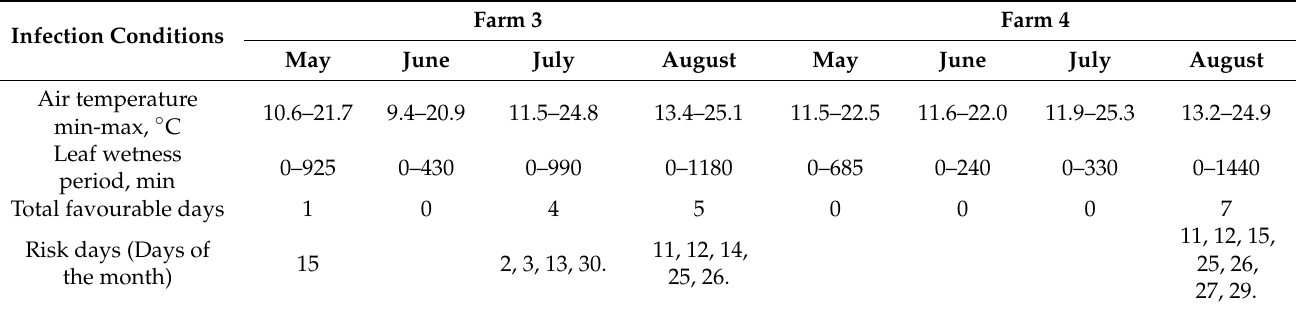
Table 2. Conditions for strawberry C. acutatum development, according to iMETOS ® meteorological station data in 2018. Infection Conditions